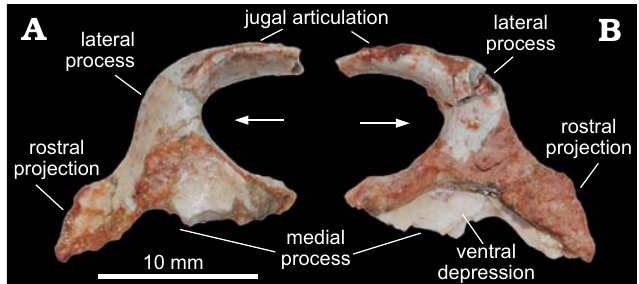
Fig. 2. Right ectopterygoid of a sauropodomorph from Sacisaurus site, Late Triassic Caturrita Formation, Agudo, Rio Grande do Sul, Brazil; MCN PV 10049 in dorsal ( A ) and ventral ( B ) views. Arrows point to